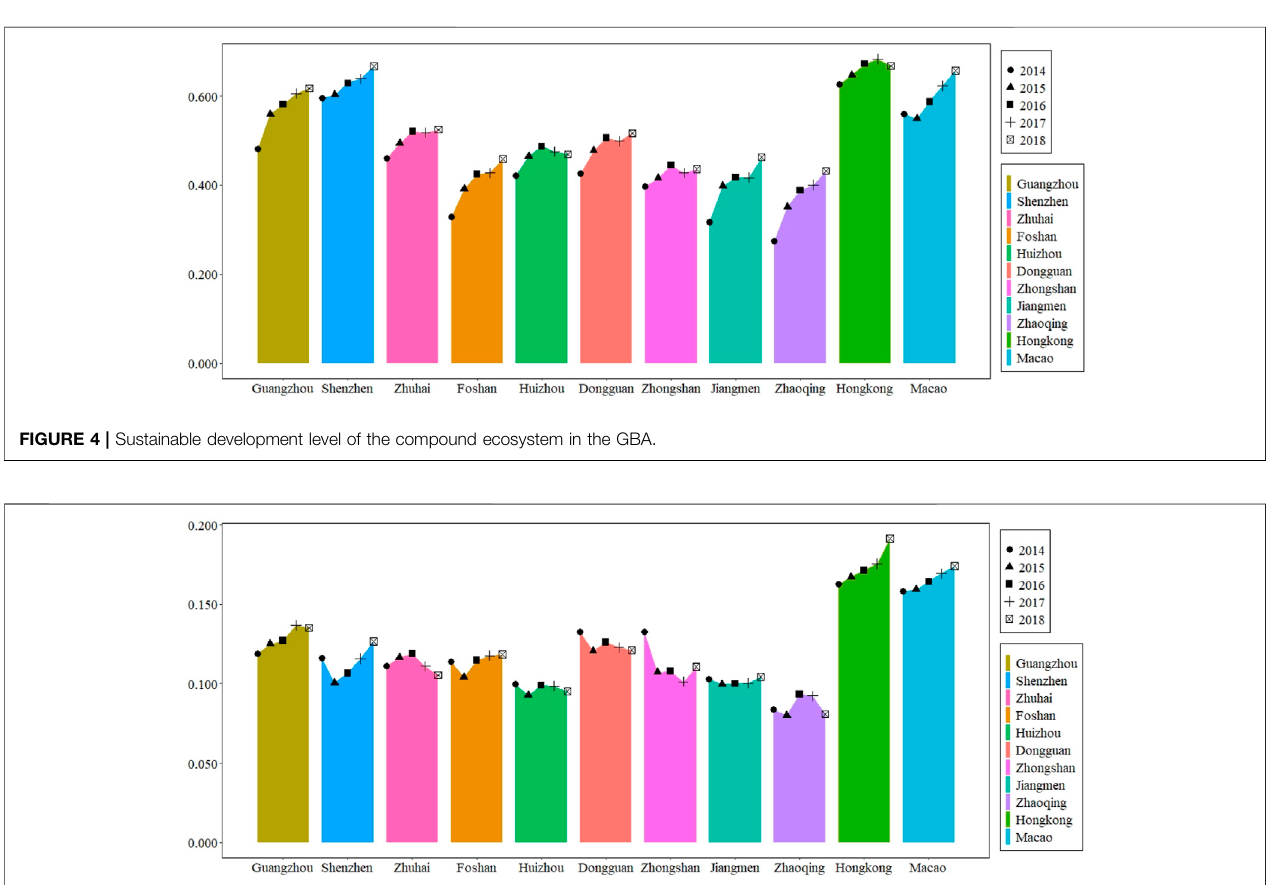
Frontiers in Environmental Science |